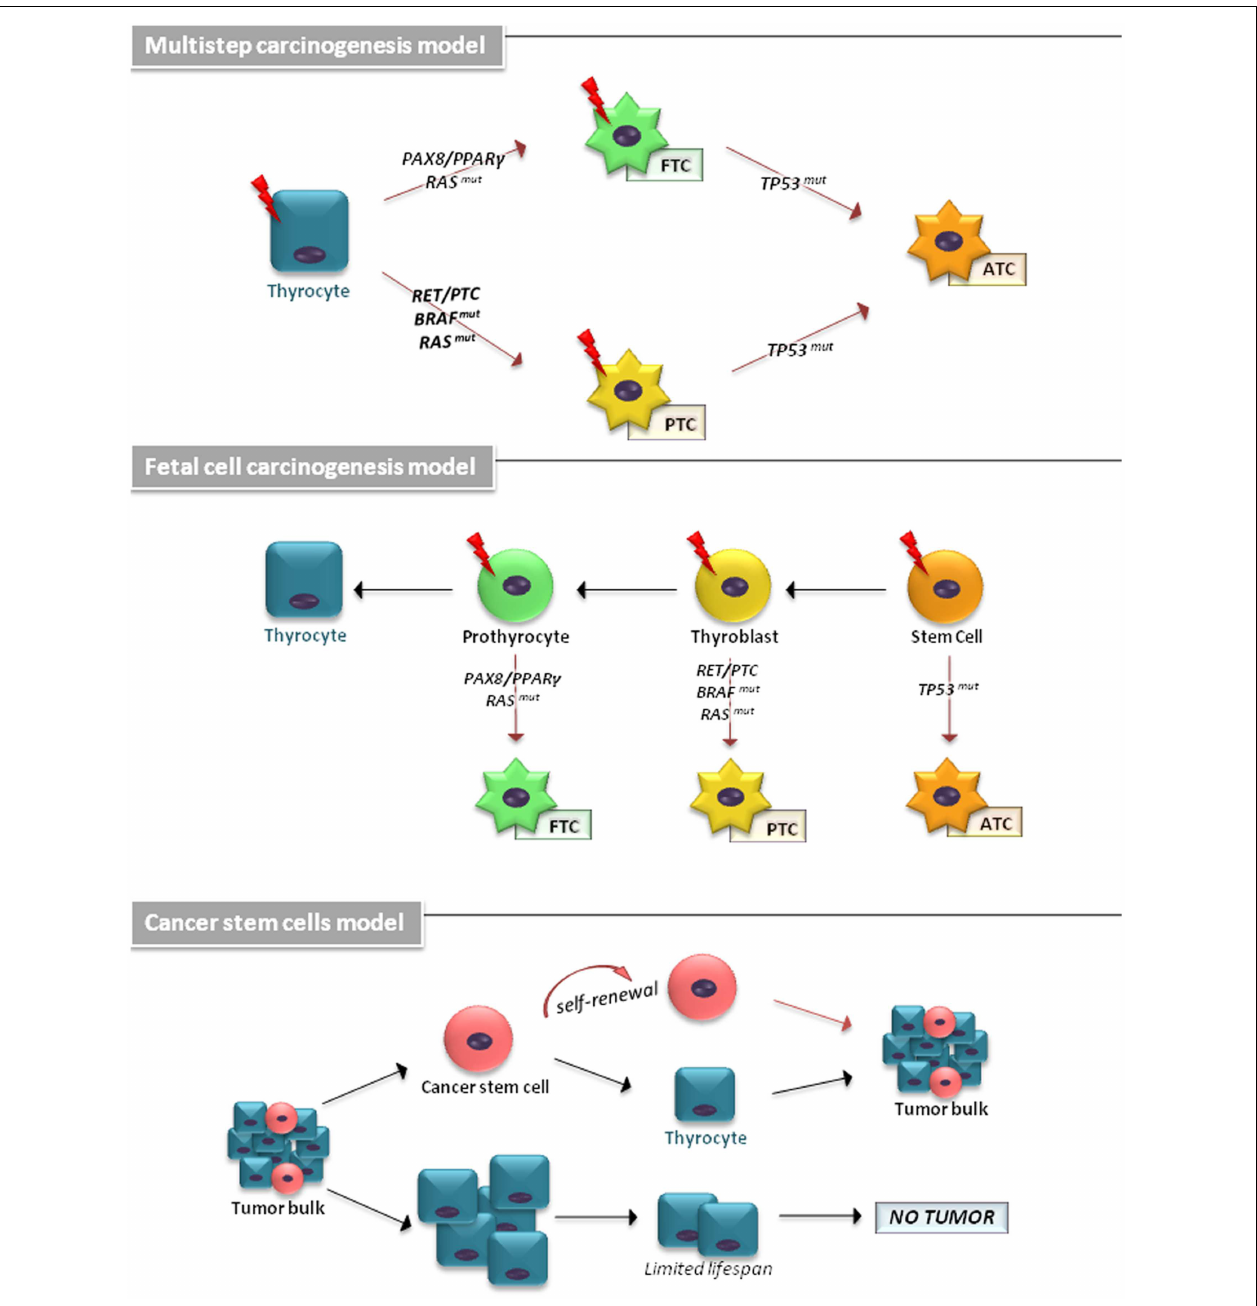
generate different forms of thyroid cancer. Fetal thyroid stem cells, characterized by expression of the oncofetal fibronectin (OF), generate ATC, thyroblasts, which express OF and the differentiation markerTg, are proposed to be the cellular origin of PTC.The more differentiated prothyrocytes, expressingTg, give rise to FTC.The cancer stem cells model proposesTC as an SC disease.The accumulation of mutations in differentiated thyrocytes leads to their transformation. A subset of these cells may (in more aggressive tumor types) dedifferentiate and assume CSC characteristics.